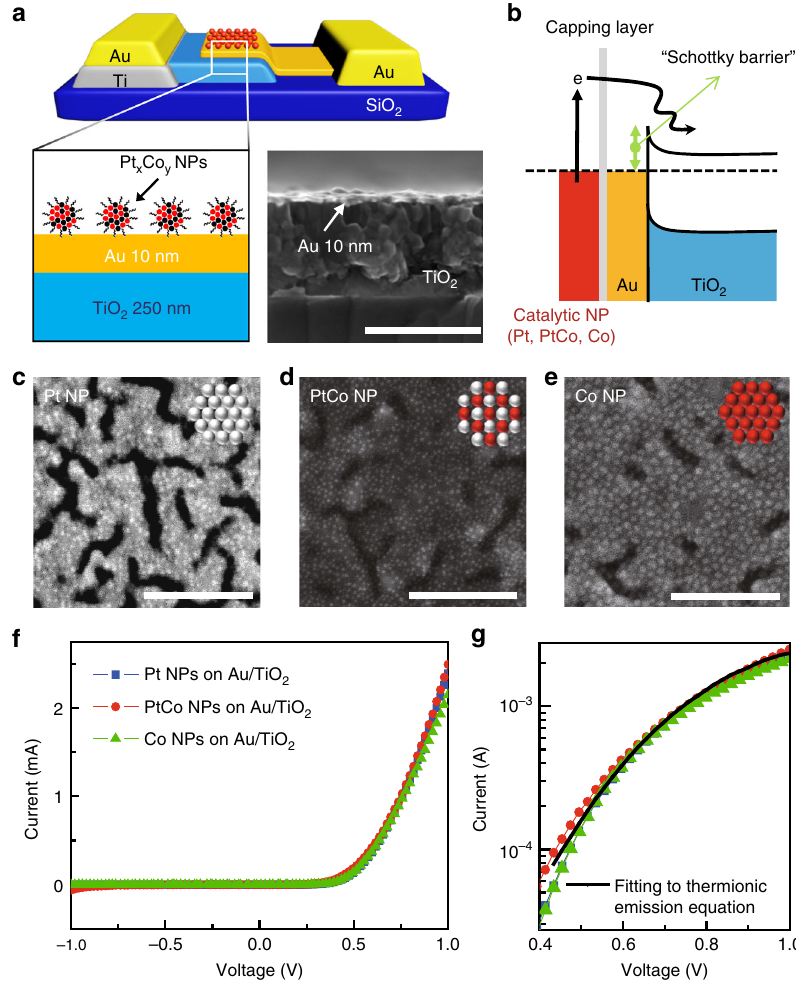
Fig. 1 Detection of hot electrons generated on PtCo bimetallic NPs. a Schematic of a NP/Au/TiO 2 catalytic nanodiode and cross-sectional fi eld emission scanning electron microscopy (FE-SEM) image of a 10 nm Au fi lm on a 250 nm TiO 2 layer. The rectifying contact is formed at the interface between the Au and TiO 2 layers. The Ti layer makes the ohmic junction with the TiO 2 . Scale bar in FE-SEM image is 300 nm. b Energy band diagram for the Au/TiO 2 nanodiode with various bimetallic NPs with different compositions. Hot electrons energetic enough to overcome the Schottky barrier can be detected as a steady-state current. Scanning electron microscopy (SEM) images of a monolayer of c Pt, d PtCo, and e Co NPs on a 10 nm Au layer. Scale bars are 100 nm ( c – e ). f Current – voltage (I – V) curves measured on the Au/TiO 2 catalytic nanodiodes with Pt (blue), PtCo (red), and Co (green) NPs. g Fitting the I – V curves of the Au/TiO 2 nanodiode to the thermionic emission equation. The catalytic nanodiodes show a Schottky barrier height of 0.7